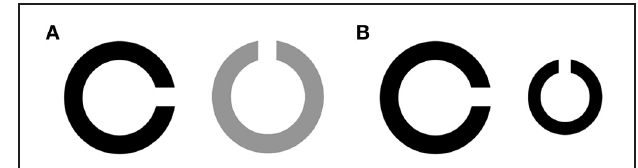
FIGURE 2 | Examples of stimuli for investigation of contrast sensitivity (A) and visual acuity